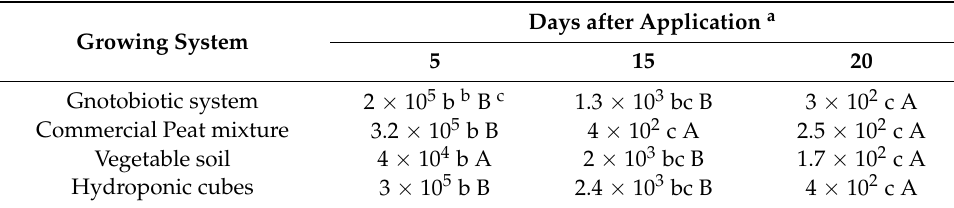
Table 2. Counts (cfu cm − 1 ) for chloramphenicol-resistant, YFP-tagged Bacillus subtilis MBI600 strain on tomato roots grown in 4 different growth